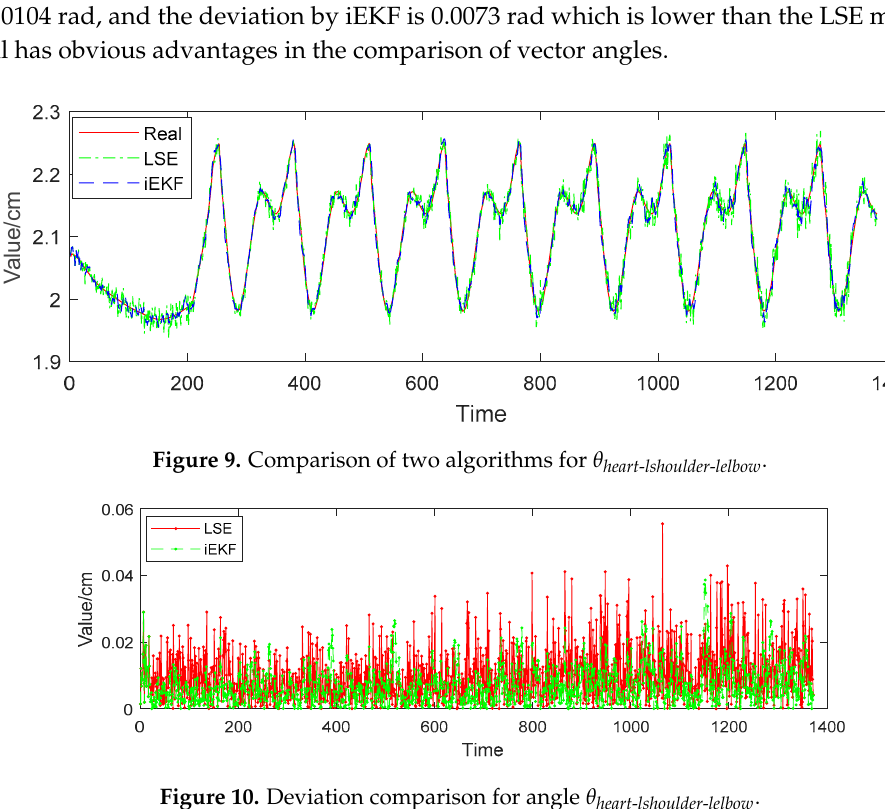
θ . Figure 10. Deviation comparison for angle θ heart - lshoulder - lelbow θ .